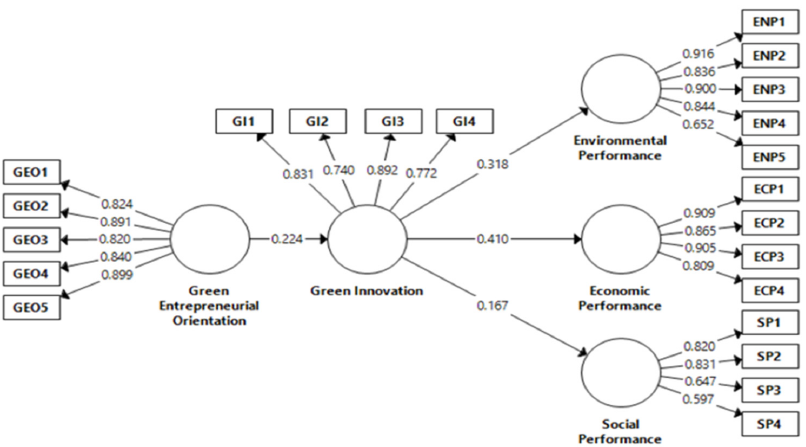
Figure 2. Evaluation of the Structural Model. Table 5. PLSpredict assessment of manifest variable.